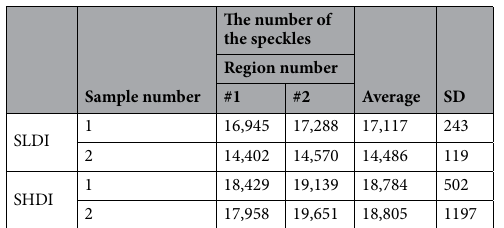
Table 1. The result of the number of the speckles at each region (SD: standard